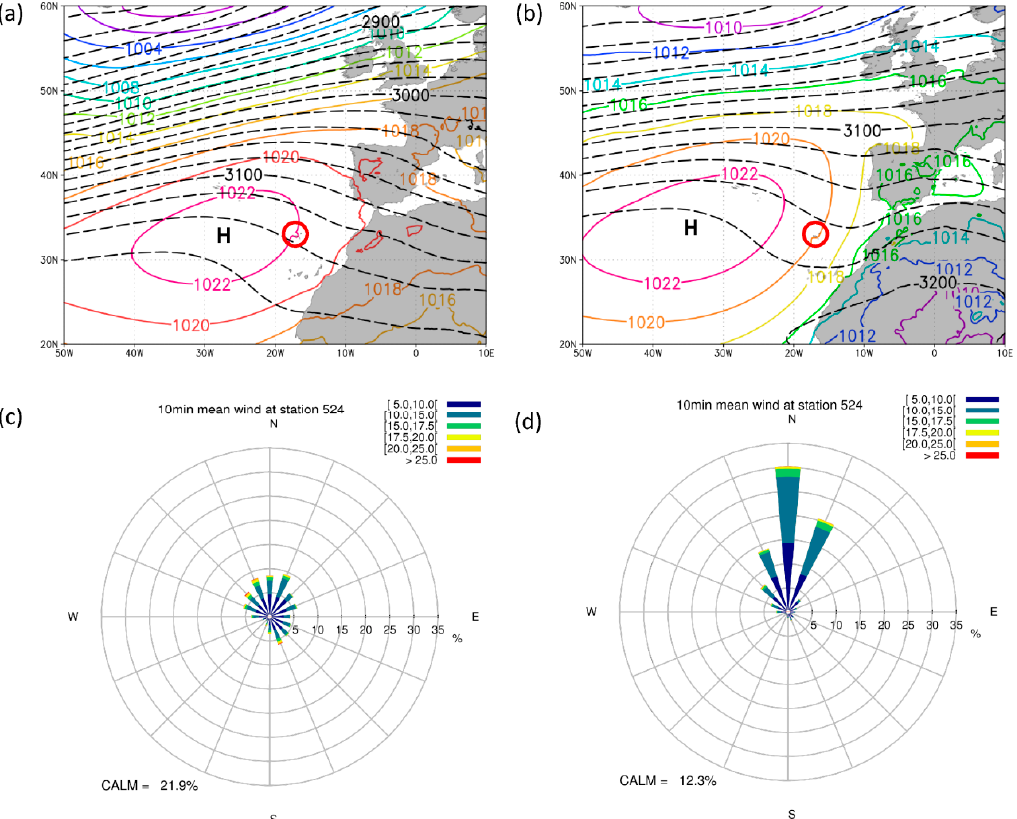
Figure 2. Composites of the daily mean sea level pressure (solid contours) and 700 hPa geopotential height (dashed contours) for ( a ) winter (October–March) and ( b ) summer (April–September) over the eastern North Atlantic and adjacent landmasses (grey shaded). The red circle indicates the location of Madeira Island. Wind roses screening the relative frequencies of occurrence (in percentage) of the average 10-min wind at 10-m height (in kt, ~0.51 ms − 1 ) in winter ( c ) and summer ( d ) at Porto Santo (station 524, see location in Figure 1a).